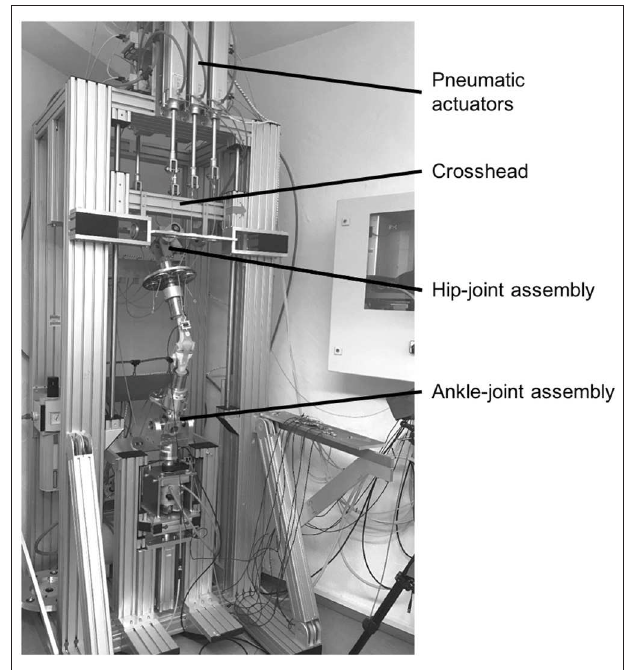
FIGURE 1 | Knee joint simulator with a knee joint model fixed between the hip- and ankle-joint assemblies, crosshead for vertical hip displacement and pneumatic actuators for muscle force